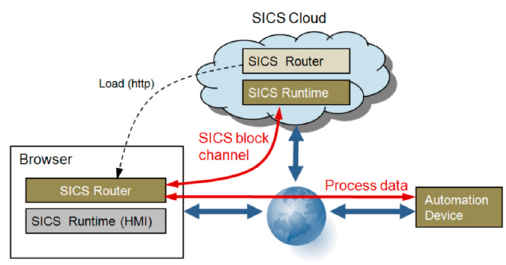
Figure 9. SICS controller in the server-based mixed mode (SMM).